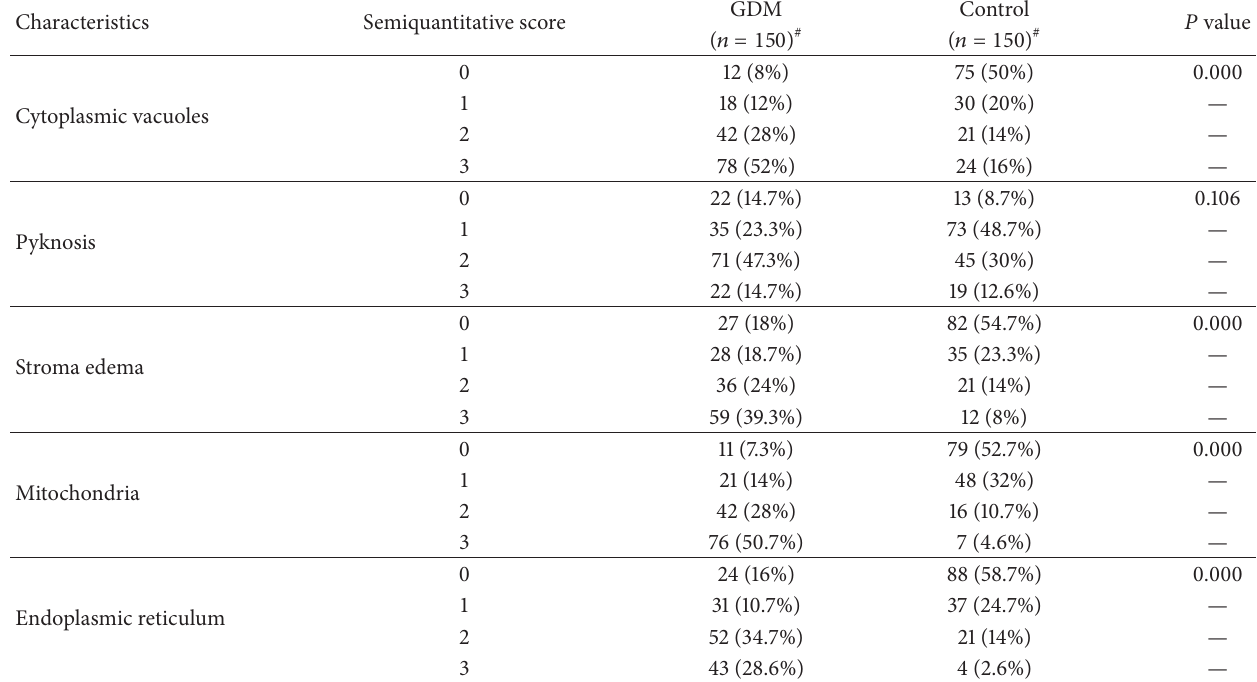
Table 3: The semiquantitative analysis of placental ultrastructures in the GDM group and control group.